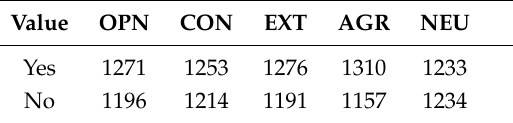
Table 3. Distributions of the essays